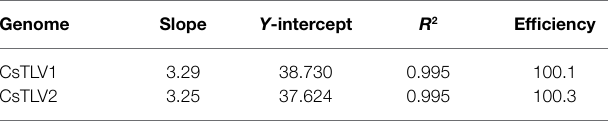
TABLE 2 | RT-qPCR efficiency with dsRNA standards. Genome